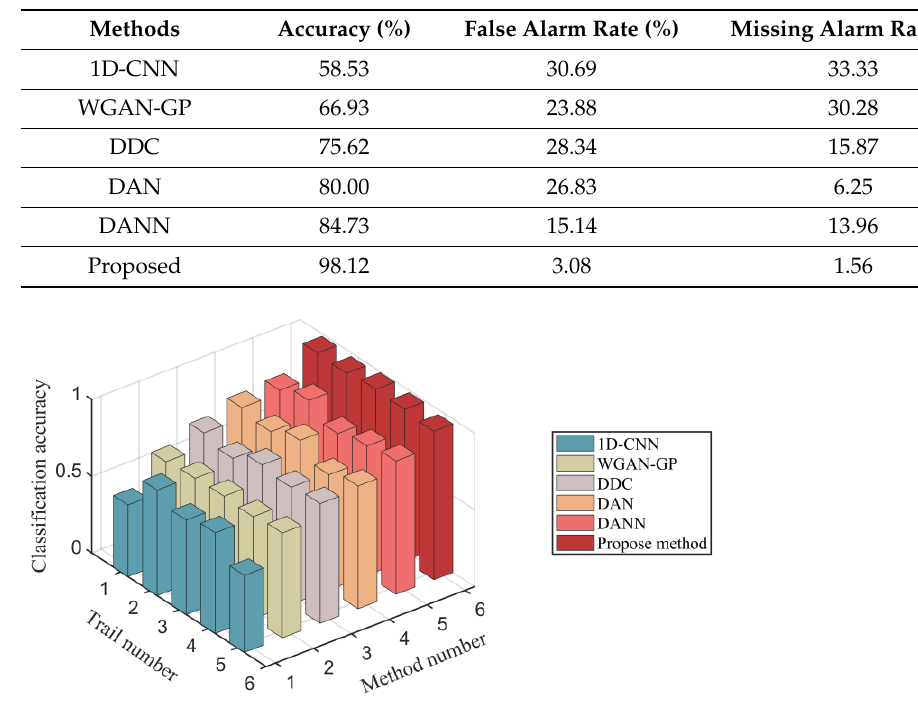
Table 4. Detection results for experimental dataset with multiple methods.